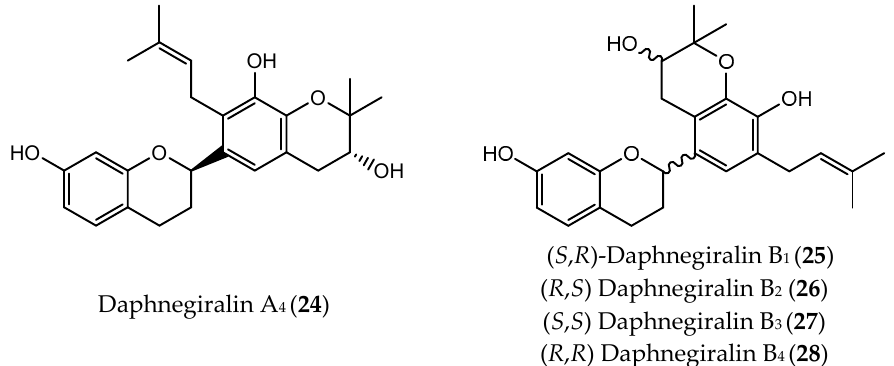
Figure 7. Chemical structure of daphnegiralin A 4 ( 24 ) and B 1 -B 4 ( 25–28 ) isolated from Daphne giraldii with antitumor activity.